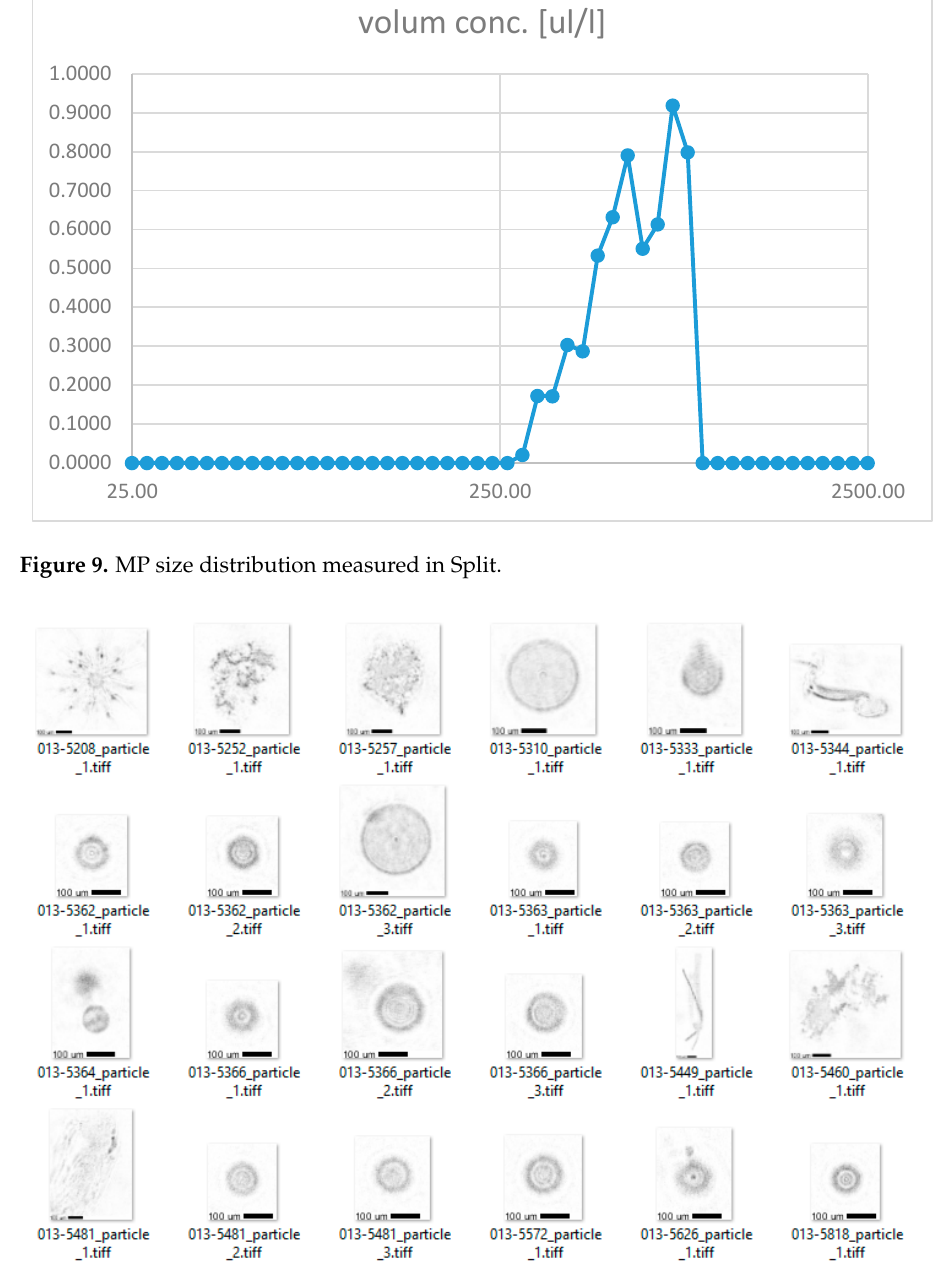
Figure 10. Subset of particles images collected for a mission.